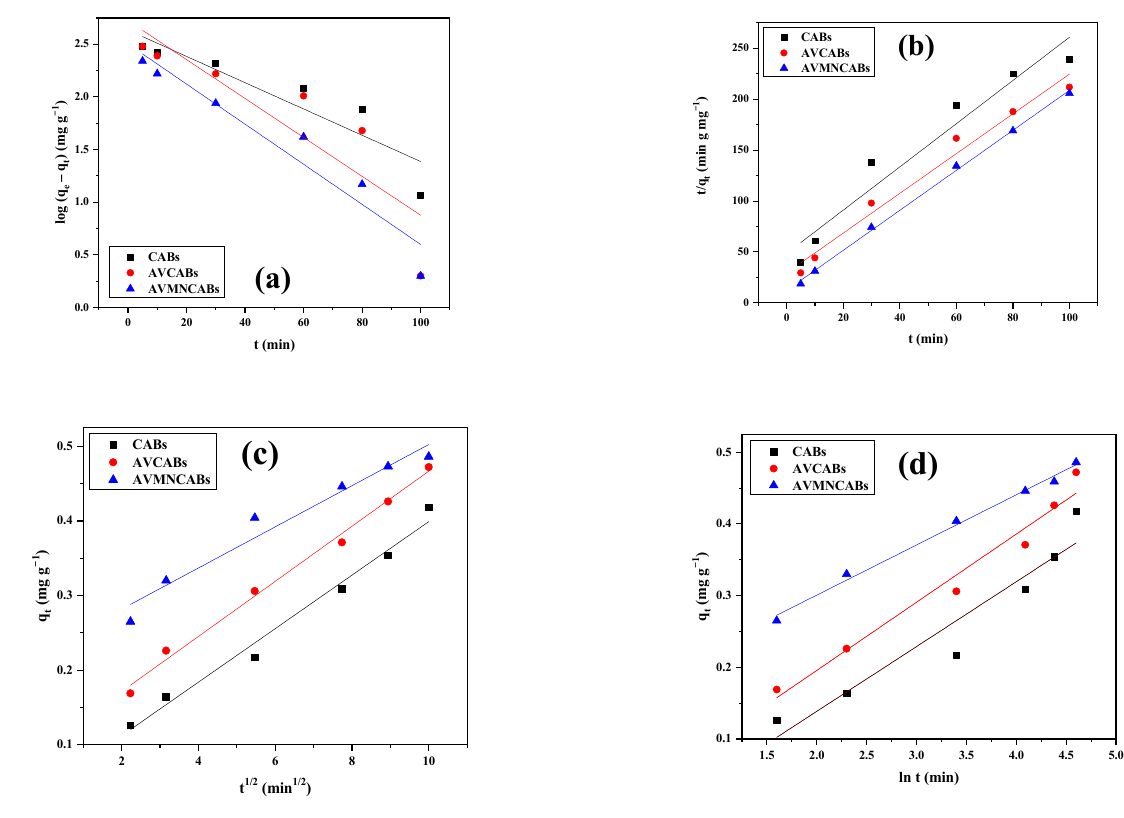
Figure 14. ( a ) Kinetic fittings for pseudo-first order, ( b ) pseudo-second order, ( c ) intra-particle diffusion, and ( d ) Elovich models. Table 3. Kinetic parameters for Cu(II) adsorption on various